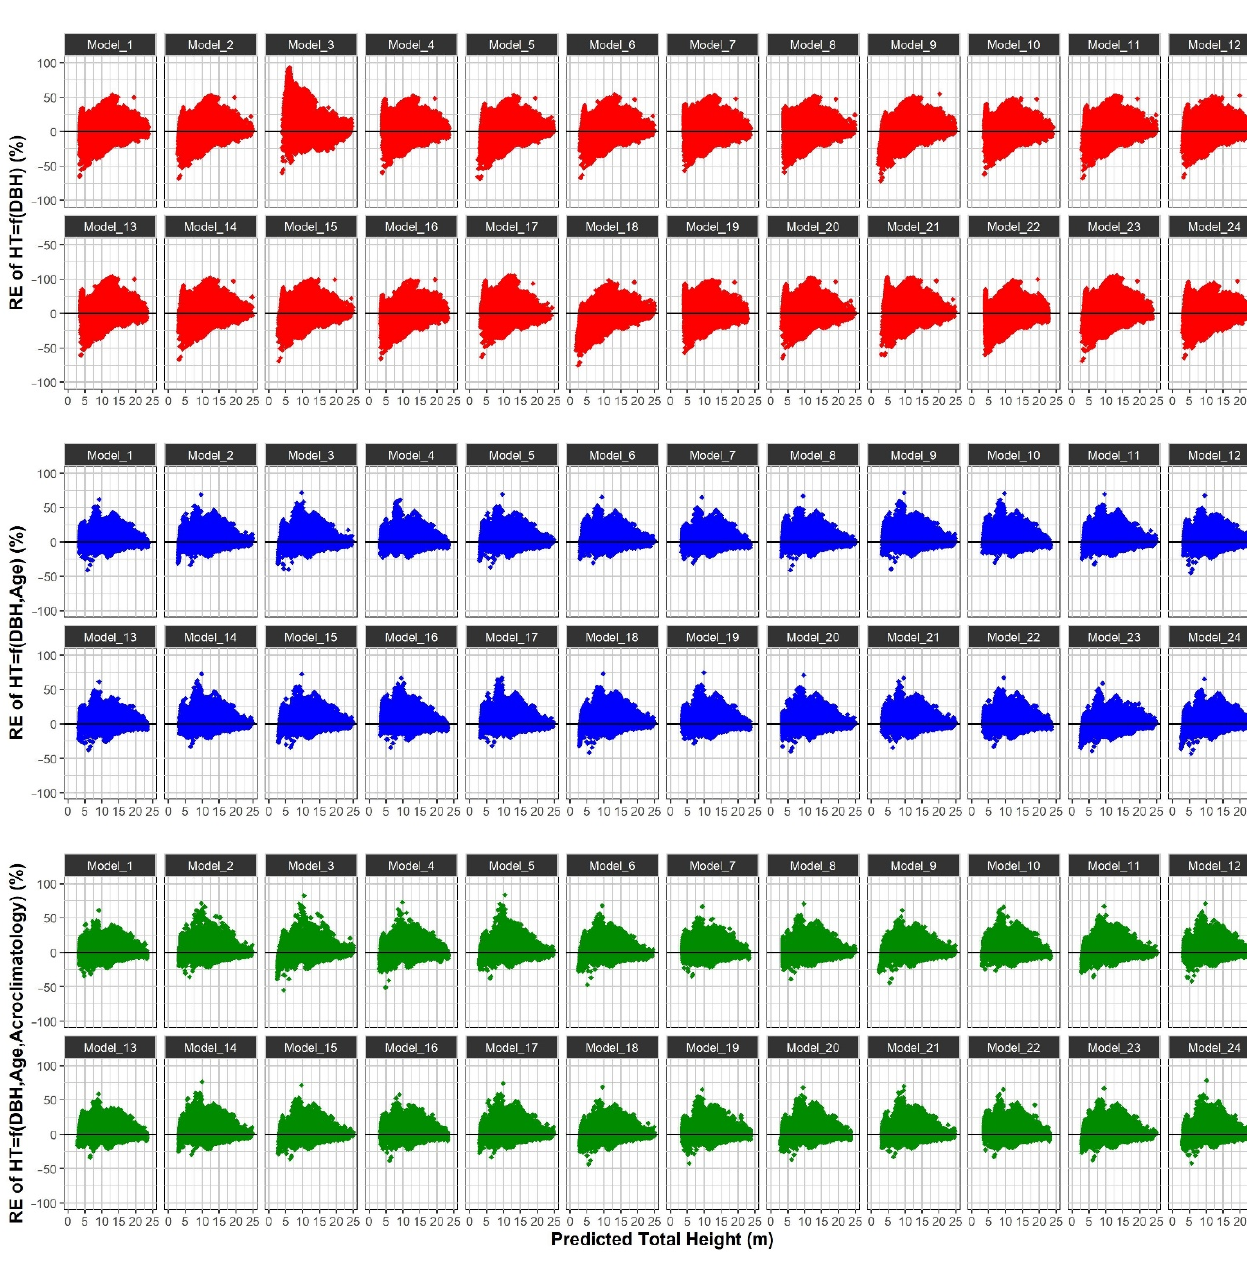
Figure 4. Residual graph in relation to the predicted total height for the hypsometric modeling of the trees of Guazuma crinita Mart. in the Peruvian Amazon, for each trained model and based on the three study functions: HT = f ( DBH ), HT = f (DBH, Age) and HT = f (DBH, Age, Agroclimatology).